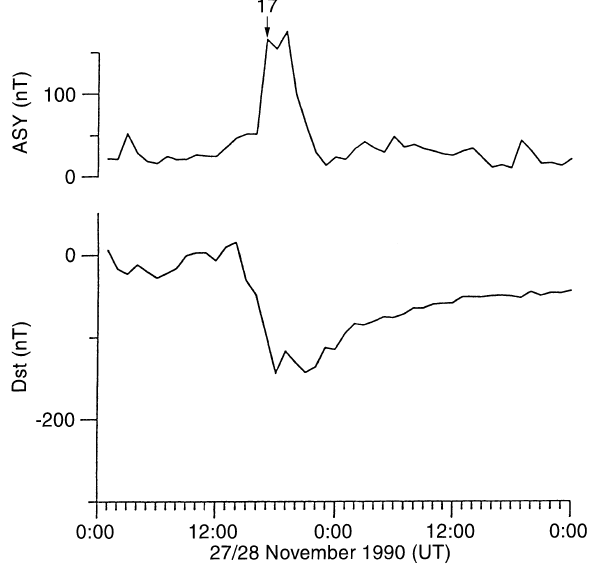
Fig. 3. Dst and ASY values of the geomagnetic X -component on 27– 28 November 1990